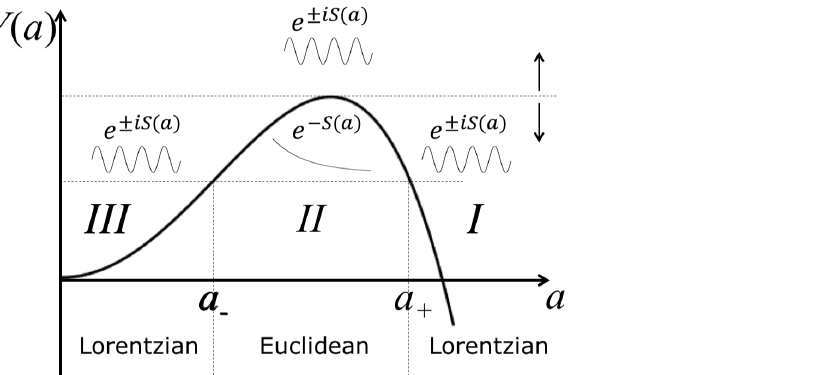
Figure 7. Potential U ( a ) . For E > 0, there are three regions: two Lorentzian regions separated by an Euclidean one. Compare it with the case E = 0 analysed in Figure